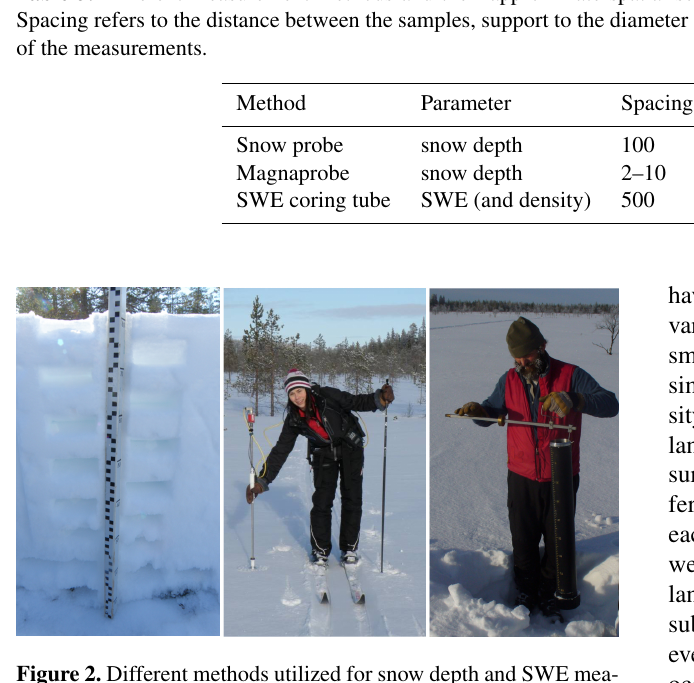
Figure 2. Different methods utilized for snow depth and SWE mea- surements during the SnowSAR-2 campaign. Conventional snow probe (left), Magnaprobe (middle), and SWE coring tube